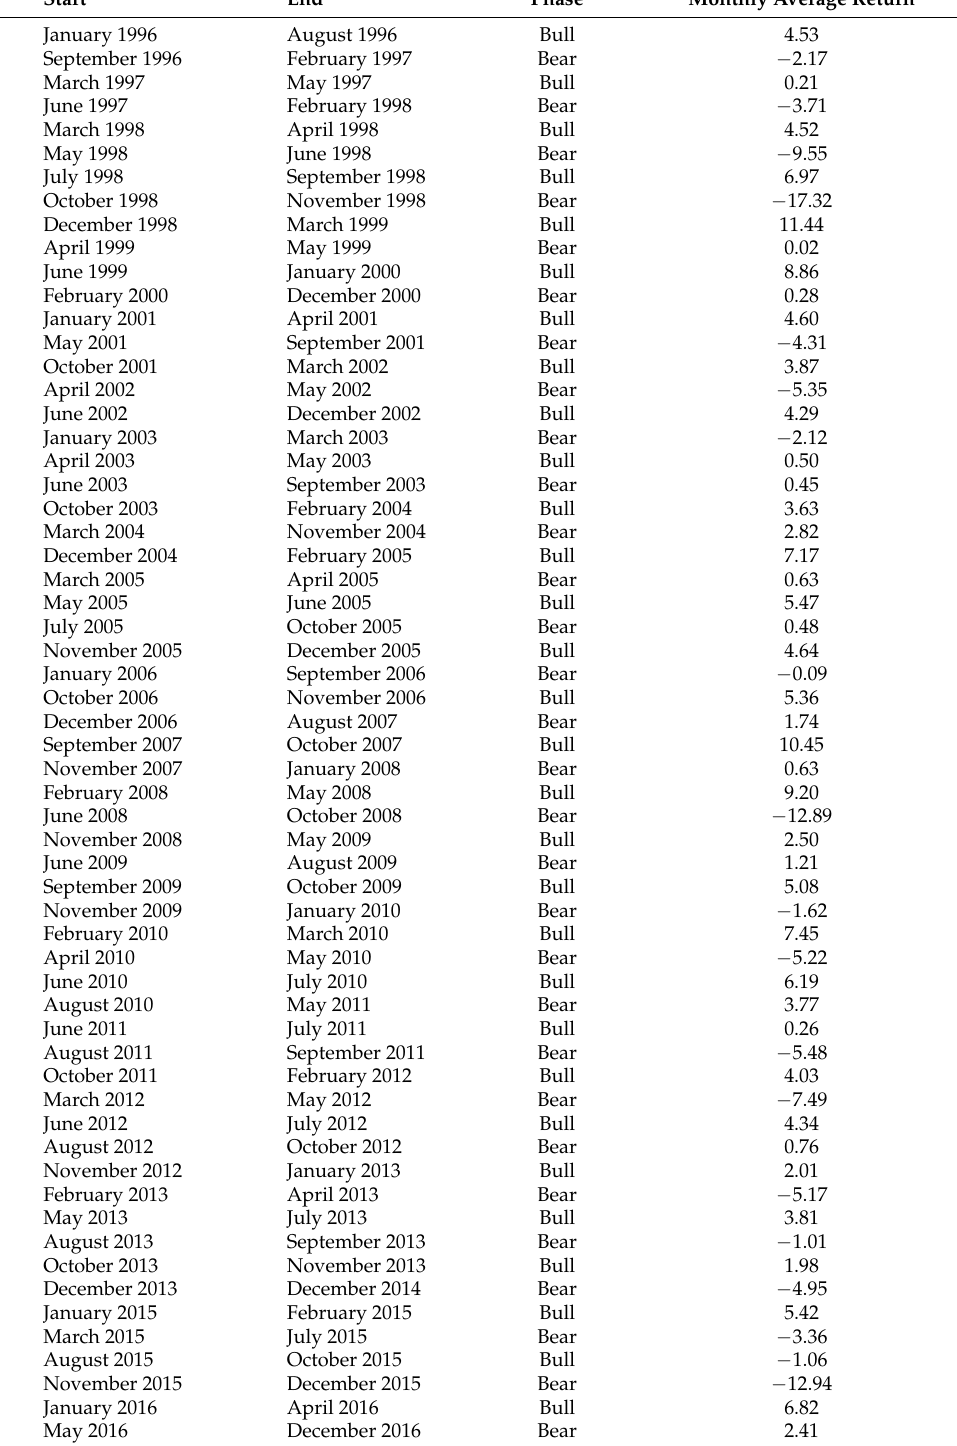
Table A2. Bull and bear phases and monthly return averages of Brent